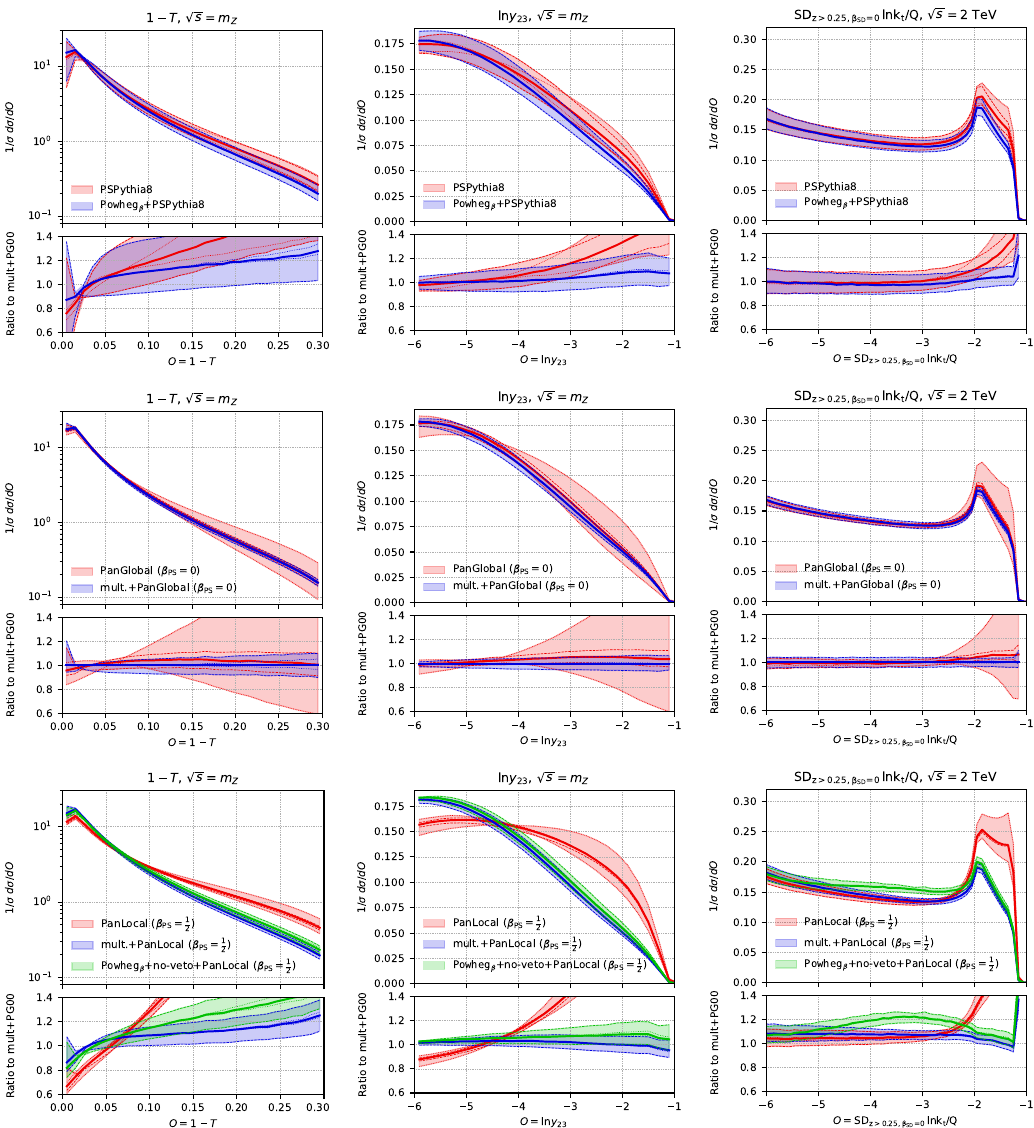
Figure 9. Thrust (left), Cambridge ln y 23 (middle) and SoftDrop ln k t /Q (right) distributions, unmatched (red) and matched (blue). They are obtained with a LL shower (our PanScales imple- mentation of the Pythia 8 shower (PSPythia 8, top row)) and two NLL showers: PanGlobal with (bottom row). The last row also shows the impact of β ps = 0 (middle row) and PanLocal β ps = 1 2 HEG-style matching without the veto discussed in section 3.3. Dotted lines show x variation, hard while dashed lines show x r